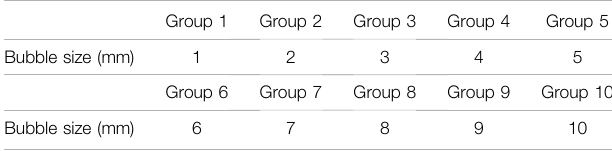
TABLE 2 | Groups of different bubble